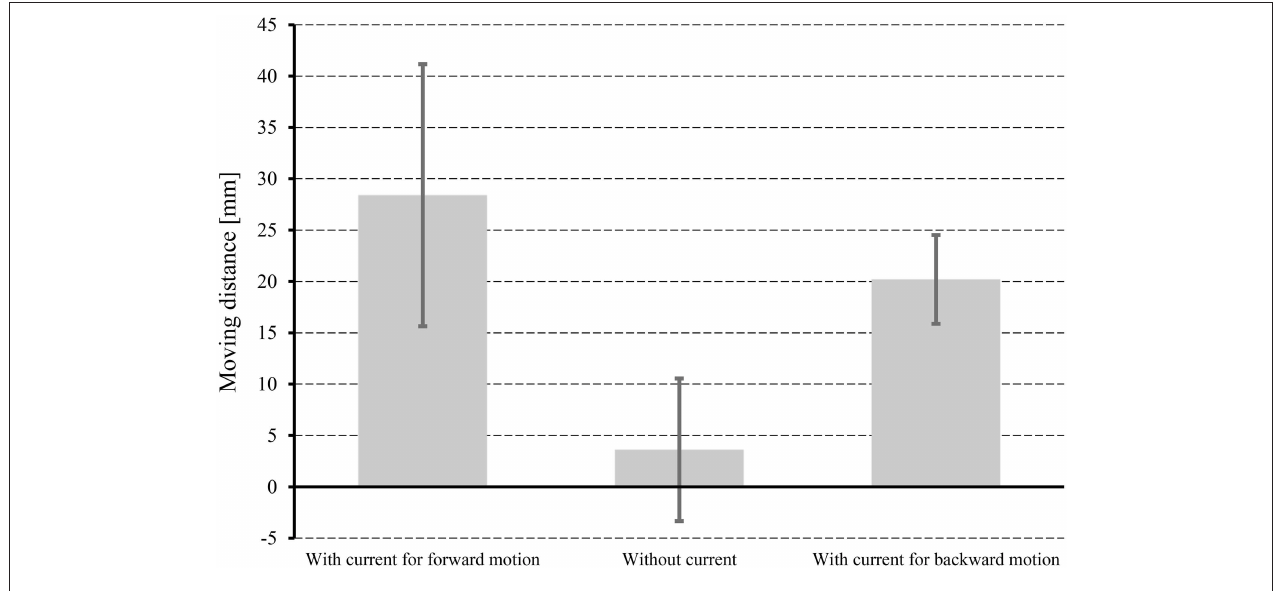
FIGURE 7 | The results of running experiments of the robot with or without current for DN gel.